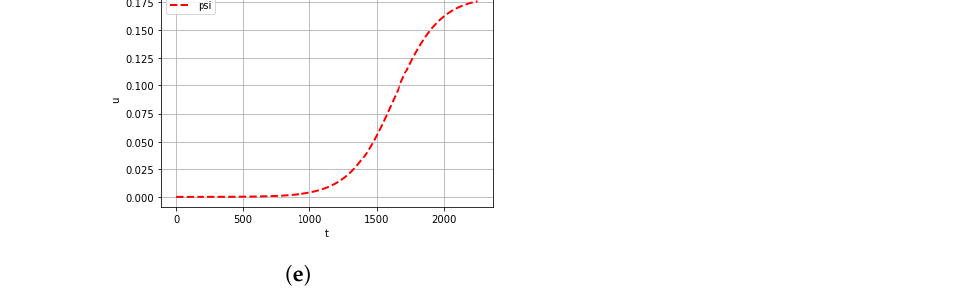
Figure 3. Dynamics of the populations of cancerous and precancerous cells without taking into account the effects of immune cells. The x -axis is the time in days. The y -axis is the number of (quasispecies) mutated pancreatic cells. There are: ( a ) single mutation cells, ( b ) two mutation cells, ( c ) three mutation cells, ( d ) KPCS cells bearing four mutations, ( e ) dynamics of nutrients intake.